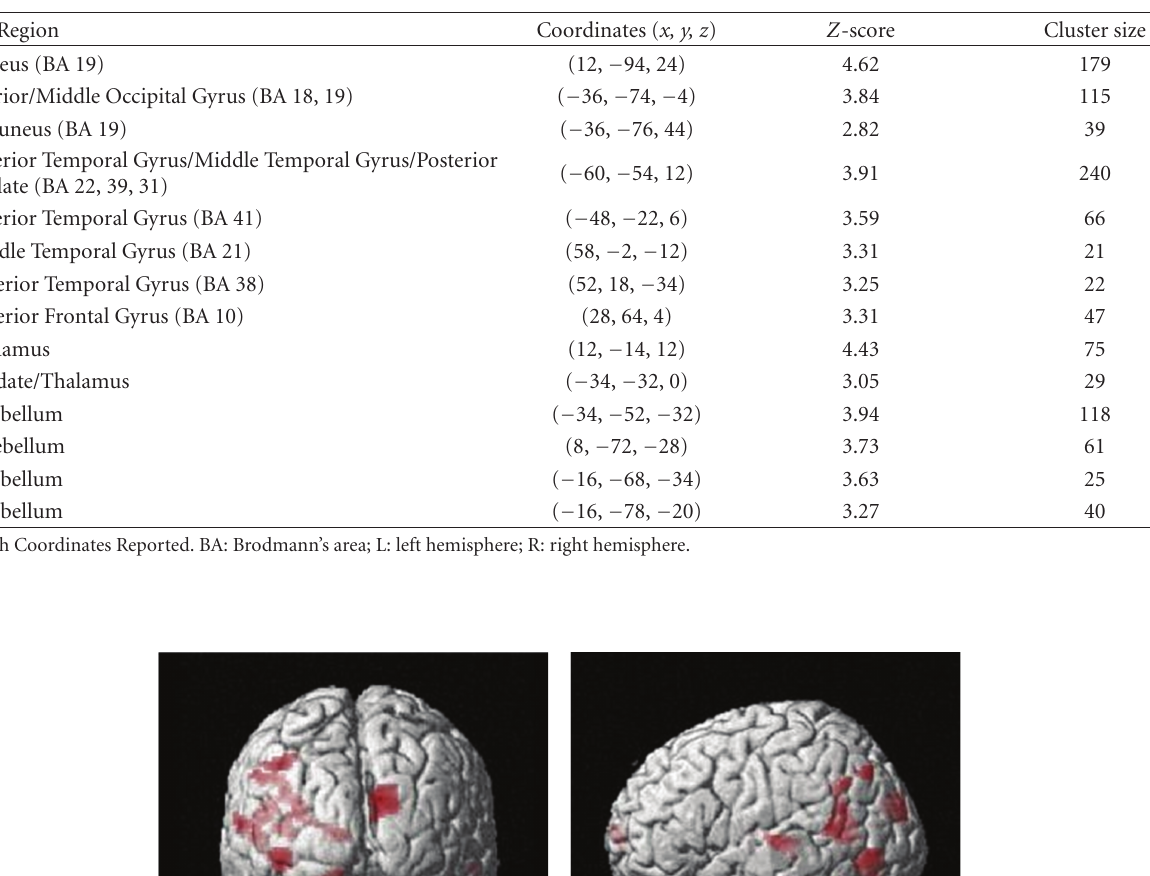
Table 3: Brain regions exhibiting a greater di ff erence in activity during the after versus before rehabilitation fMRI session in the comparison between past and control conditions.